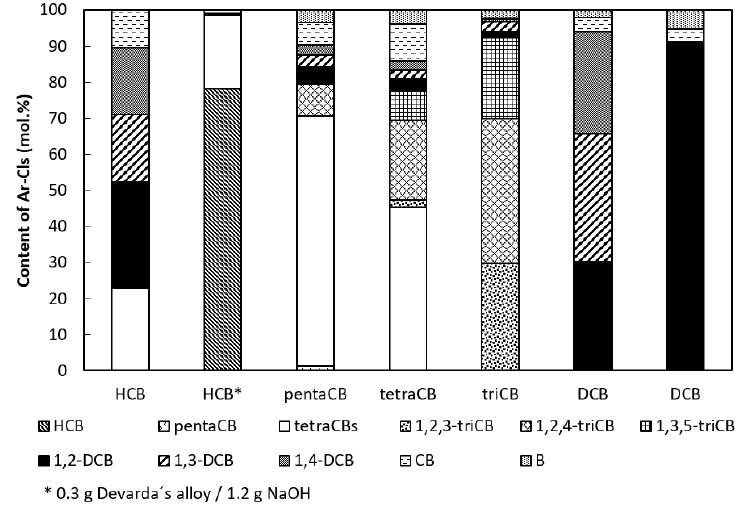
Figure 4. The composition of obtained reaction mixtures after HDC of different polychlorinated benzenes using Devarda’s Al-Cu-Zn alloy (for more details see Supplementary Materials, Table S1). The experimental procedure is described in Section 4.2.2.